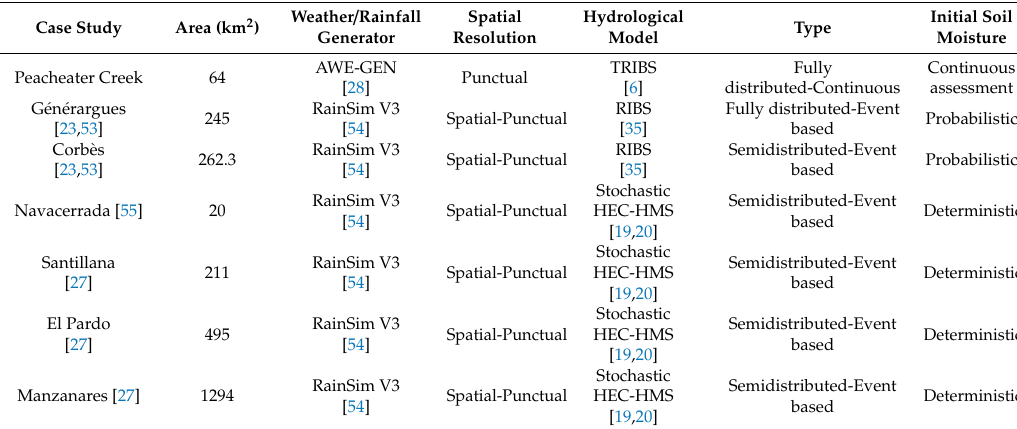
Table 8. Comparison between similar case studies and the methodology used in each of them. For comparison purposes, the basin area, weather / rainfall generator, hydrological model and the way of accounting soil moisture are